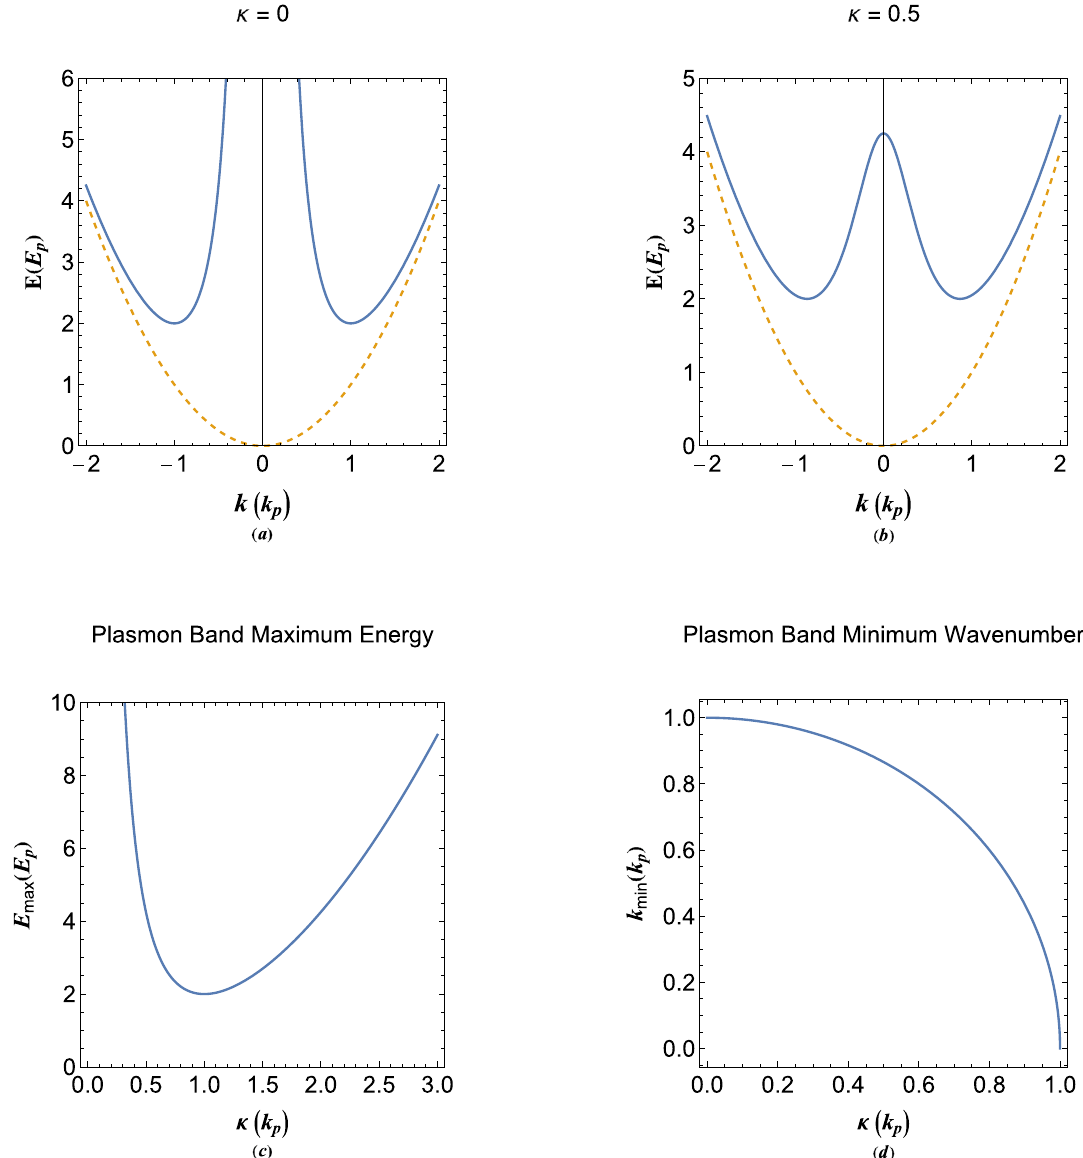
Figure 5. ( a ) The energy dispersion of collective modes in metallic region without damping effect. ( b ) The energy dispersion of damped plasmons in the tunneling region (vacuum) for the given value of the damping parameter ( κ = 0.5 ). ( c ) The maximum energy band values in damped plasmon excitations in Fig. 5b as a function of the damping parameter. ( d ) The minimum energy band wavenumber of damped plasmons (conduction band) as a function of the damping parameter. The dashed curves in plots ( a , b ) show the free electron